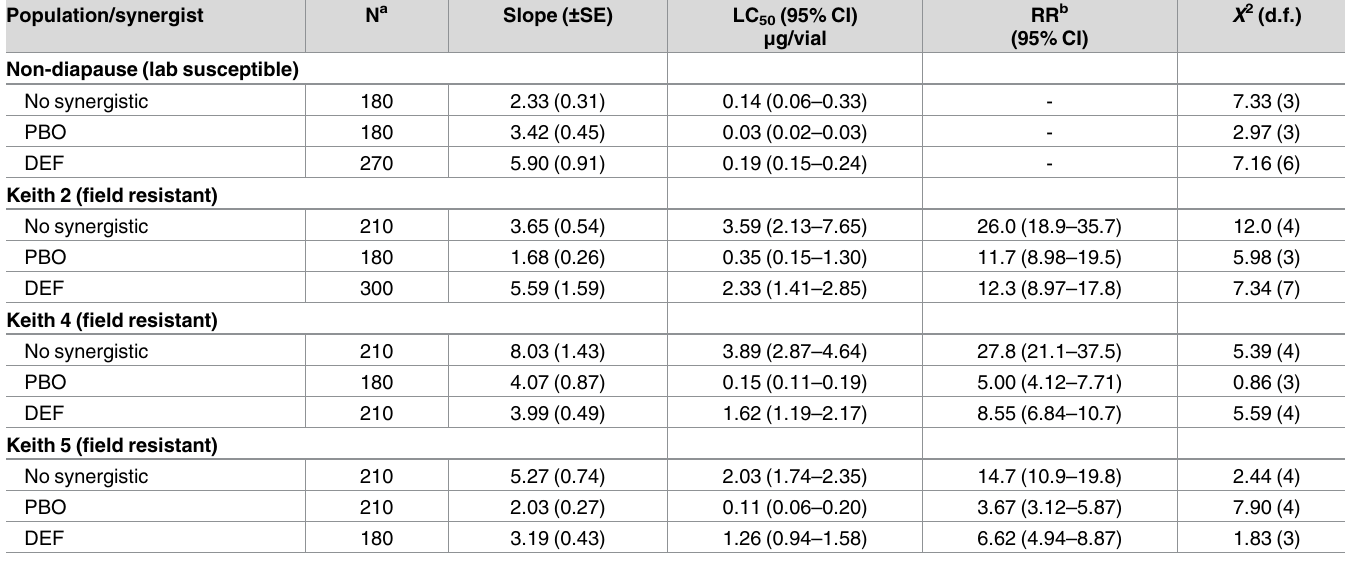
Table 3. WCR adult susceptibility of field populations to tefluthrin with and without synergistsPBO (cytochrome P-450monooxigenasesinhibitor) and DEF (esterases inhibitor) and respective